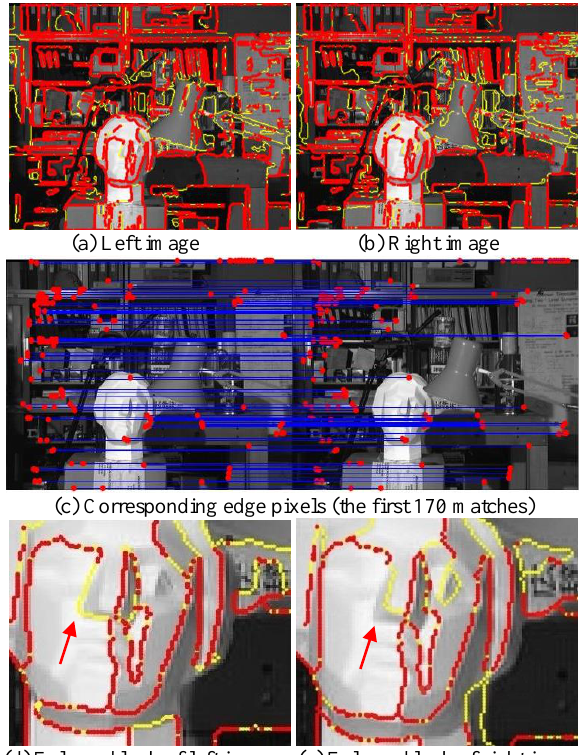
Figure 3. Demonstration of the edge pixel